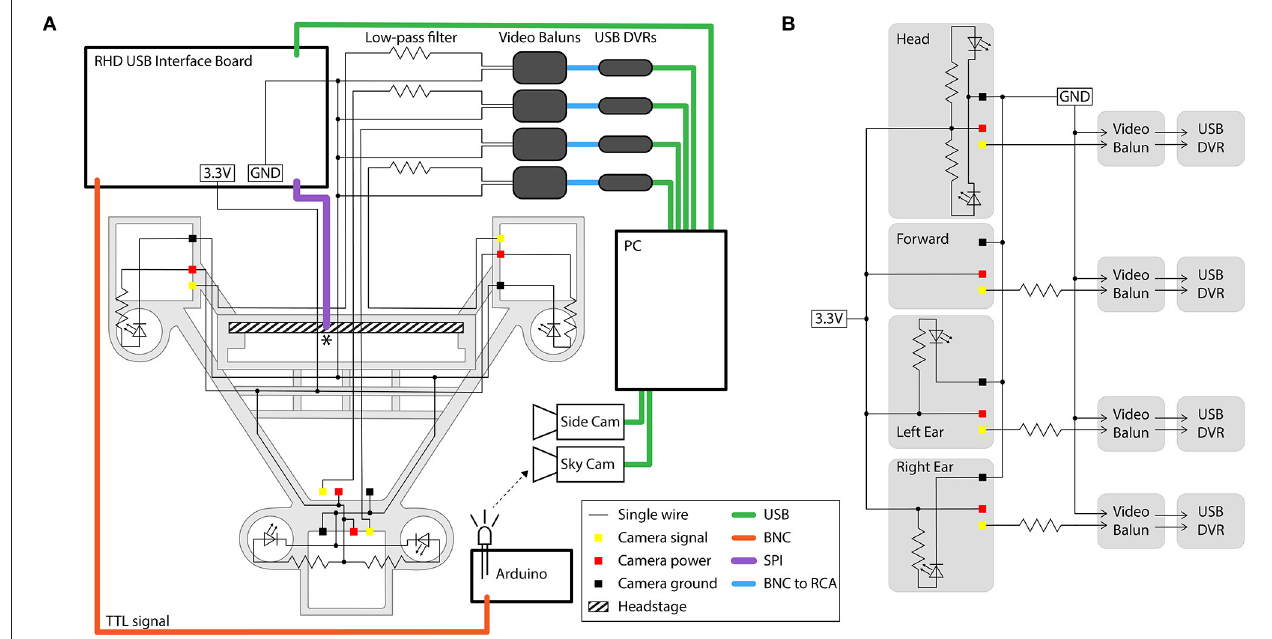
FIGURE 7 | Circuit diagram and connections for the four-camera headstage-integrated headset. (A) The camera carrier (same as Figure 2A iii) is shown in the background in gray. The RHD 32-channel headstage is represented by the hatched rectangle, and is attached to its associated SPI cable represented by the purple line at the point marked *. TTL pulses sent to the RHD 2000 USB Interface Board are relayed through a BNC cable (orange) to an Arduino Uno for synchronization of electrophysiology and video signals by illumination of an IR LED in view of the webcam placed above the arena (the SkyCam). Yellow, red, and black squares represent the soldering locations on the camera modules for the signal, power, and ground wires. Low-pass filters are constructed on a breadboard, and are then connected to video baluns through a BNC connection. From the video baluns, the signal passes through a BNC to RCA connection (blue) to the USB DVRs. Green lines represent USB cables. Black dots indicate logical connections of signals and components; for true solder locations, see the instructions in the Appendices . (B) Conventional circuit diagram for powering and signal processing of the analog cameras, same circuit as shown in (A) but without illustration of cable type or spatial